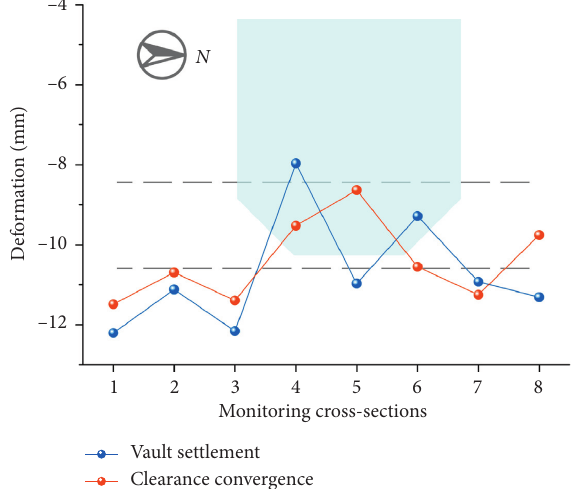
Figure 20: Longitudinal tunnel deformation